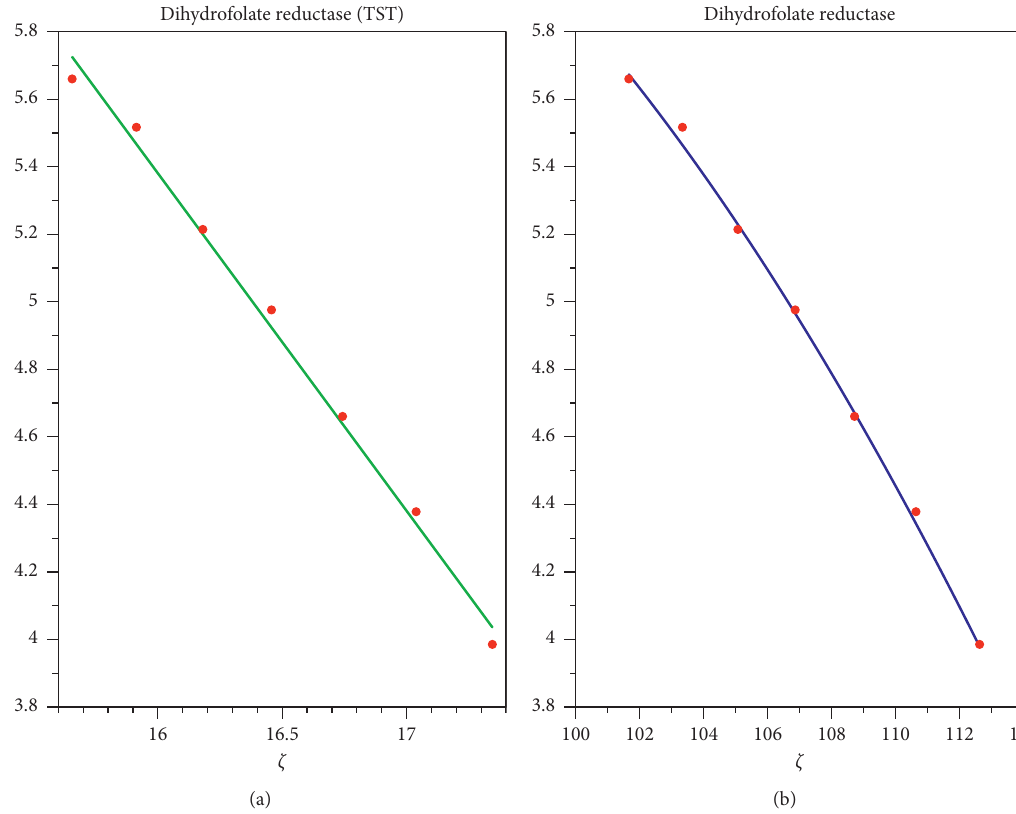
Figure 5: Eyring plots [3] according to TST (green) of rate coefficients for hydride transfer catalyzed by Escherichia coli dihydrofolate reductase in 33% glycerol. The corresponding curve from equation (8), with a � 96 , ] ( z shown in blue and the experimental data in red.